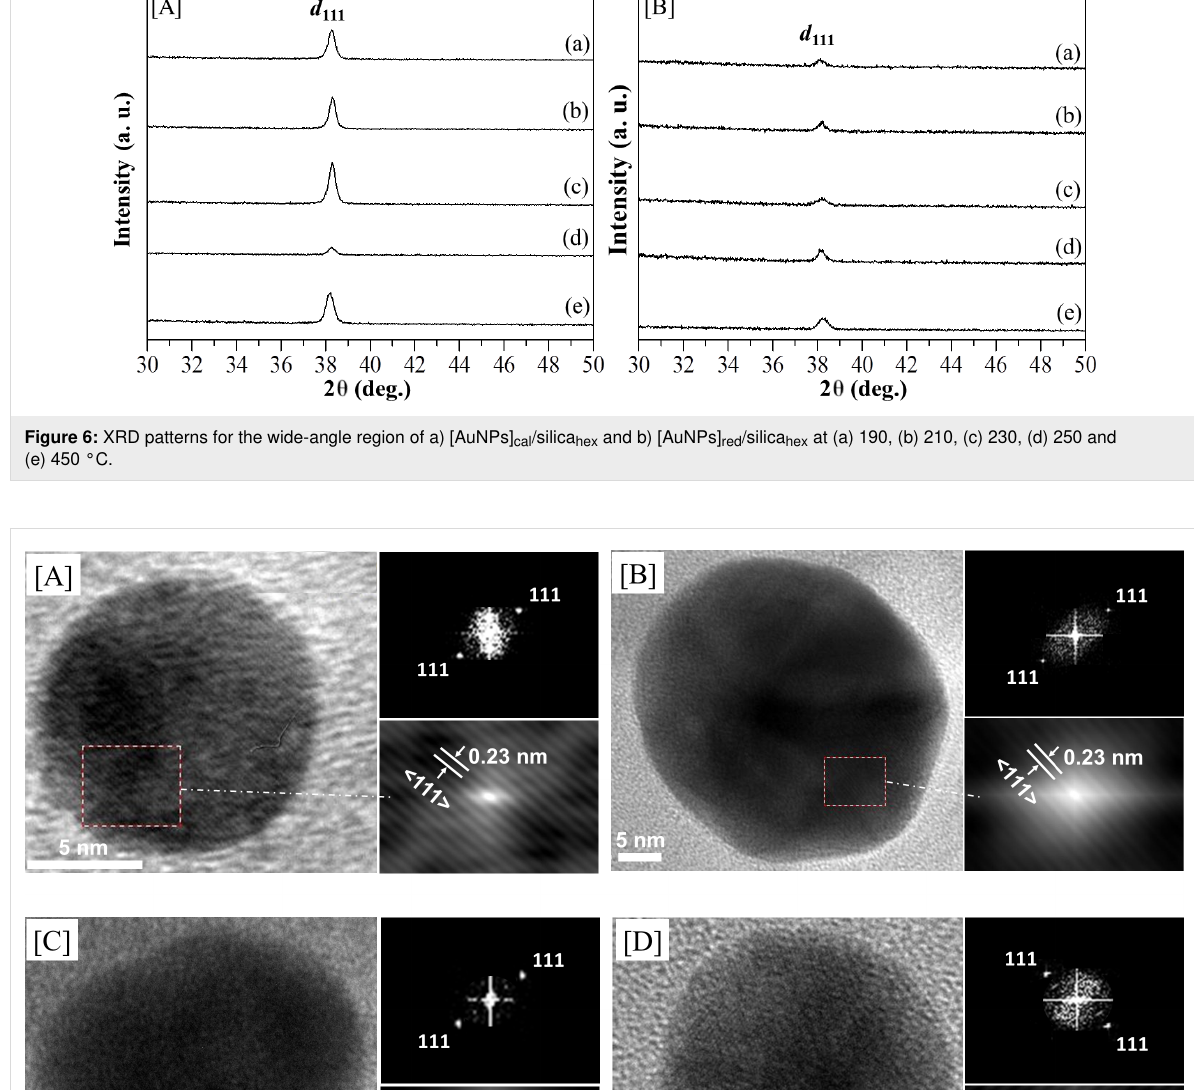
Optical properties of